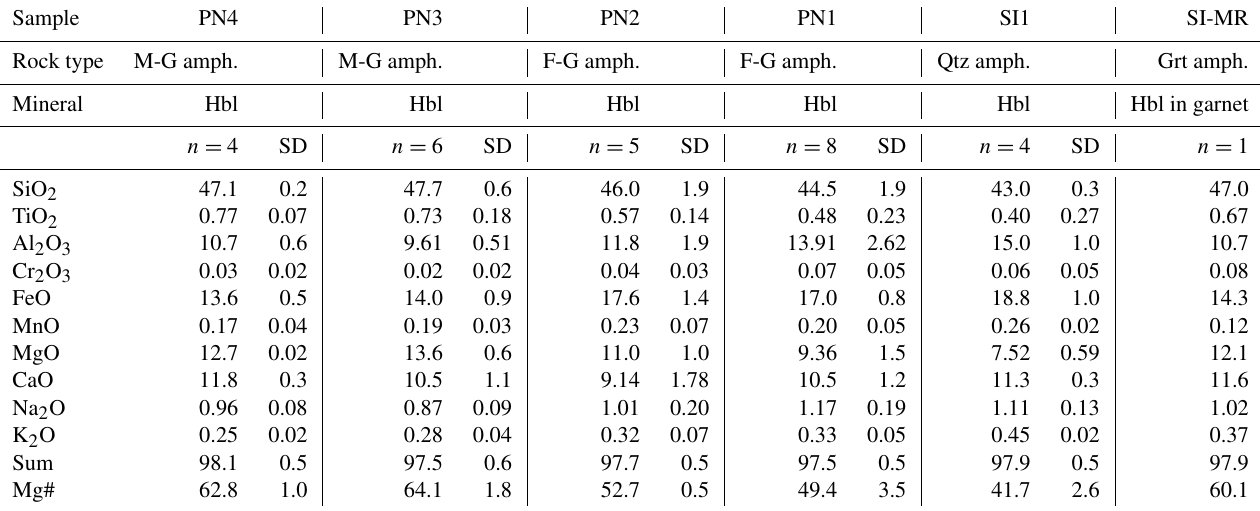
Table 4. Electron microprobe analysis of hornblende (average values,